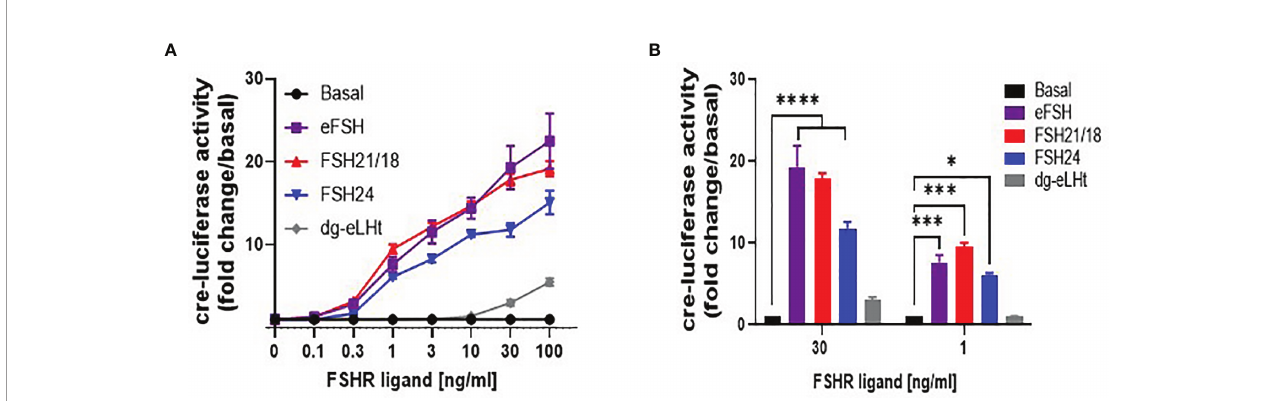
FIGURE 4 | Differential FSH ligands stimulate cre-luciferase activity in a concentration-dependent manner. HEK293 cells were transiently expressing HA-tagged FSHR, cre-luciferase and Renilla luciferase plasmids. Cells were treated in serum-free media for 4-6 hours with increasing concentrations (0-100 ng/ml) of eFSH, FSH21/18, FSH24 or dg-eLHt. (A) concentration-dependent effects of FSH ligands on cre-luciferase activity, represented as fold change/basal. (B) Extrapolation of data from (A) to measure the effect of ± 30- and ± 1 ng/ml of eFSH, FSH21/18, FSH24 or dg-eLHt on cre-luciferase activity. Data represented as fold change/basal and analyzed using ordinary two-way ANOVA. All data points were normalized to the internal transfection ef fi ciency control, Renilla -luciferase. Each data point represents mean ± SEM for 3-5 independent experiments, measured in triplicate. * p < 0.05; ** p < 0.01; *** p < 0.001; **** p <